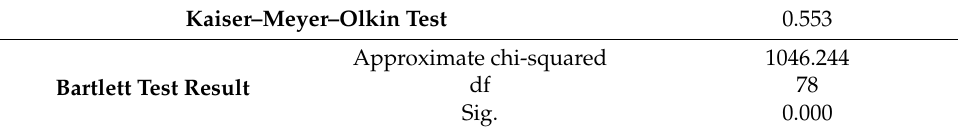
Table 1. KMO and Bartlett test